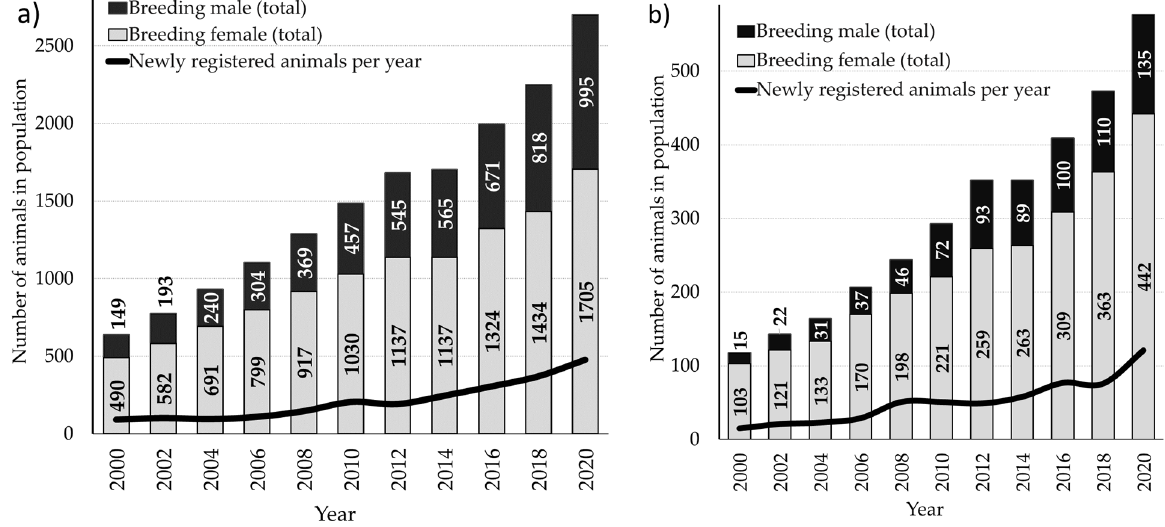
Figure 1. The number of males, females, and newly registered animals in a year, concerning the Littoral-Dinaric donkey ( a ) and Istrian donkey ( b ) populations.